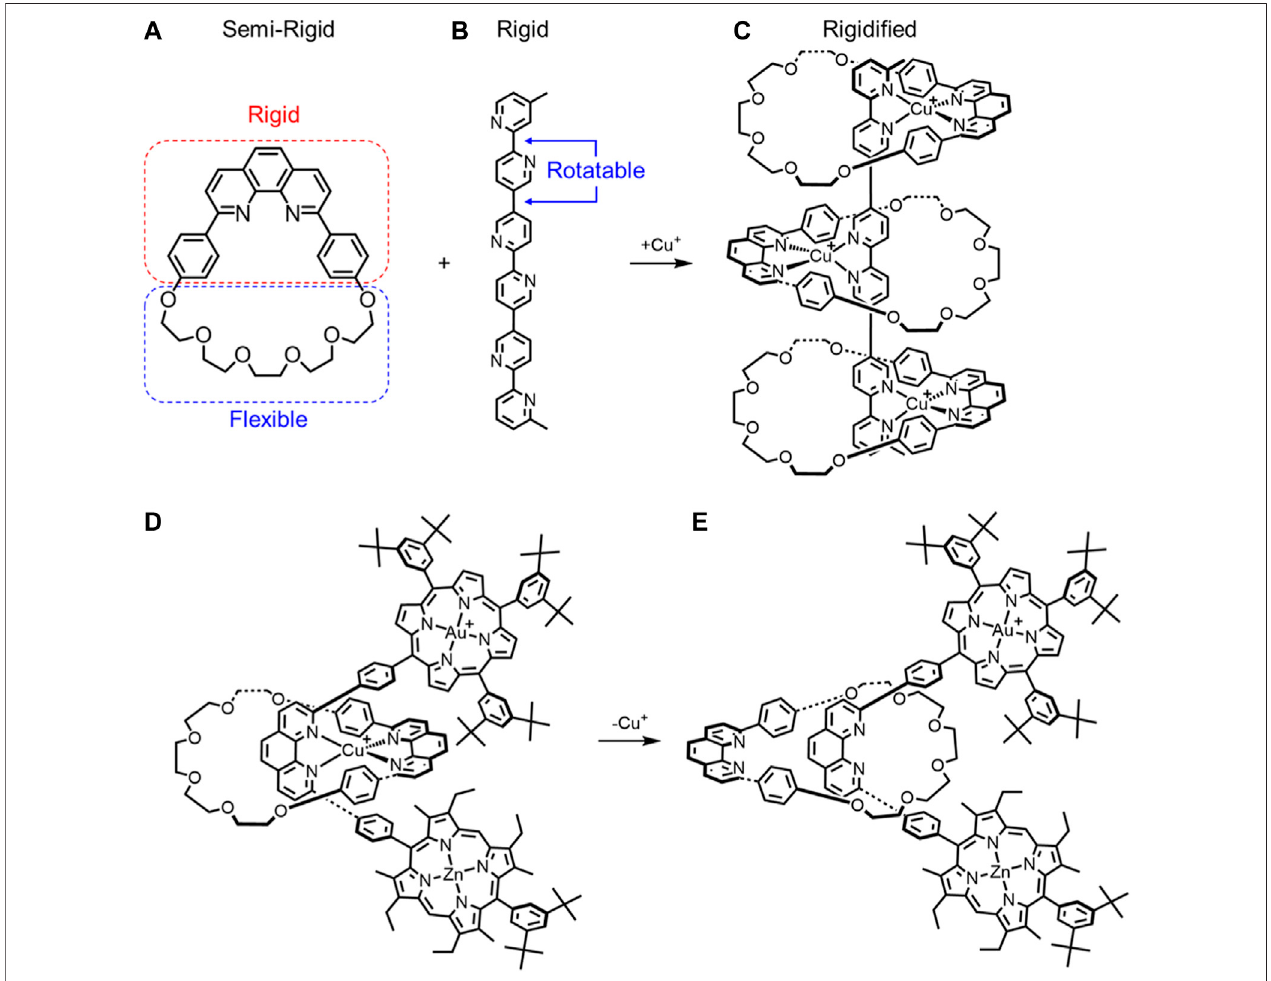
FIGURE 5 | (A) Semi-rigid macrocycle and (B) rigid thread combine to make a (C) rigidi fi ed pseudorotaxane upon Cu + complexation. A rotaxane composed of a semi rigid macrocycle and rigid thread have different macrocycle rotational conformations upon (D) metal complexation and (E) decomplexation.